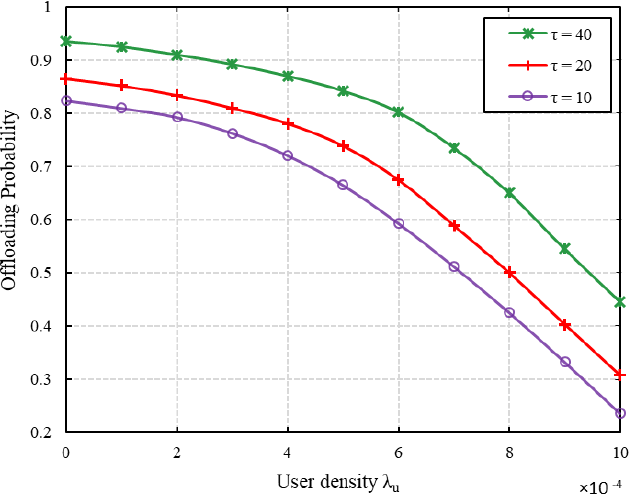
Figure 2. Comparison of offloading probability versus user density λ u with different values of sending time τ .